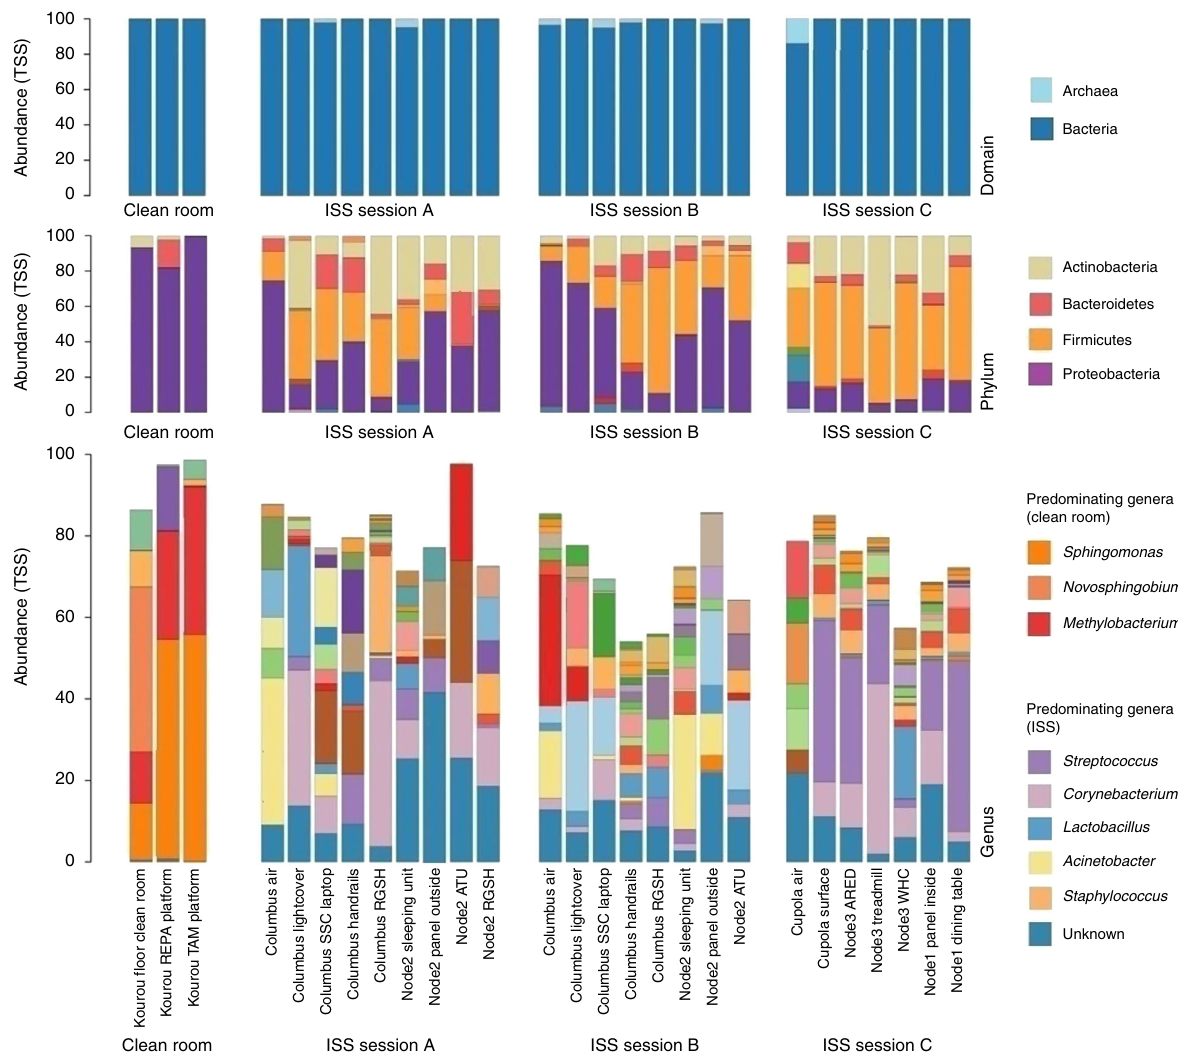
Fig. 1 Microbiome composition in clean rooms (left column) and the ISS. Samples were taken during session A, B, and C. A full version (with additional details) of the fi gure is available in the Supplementary Fig. microbiome composition (Supplementary Fig. 3c, d). Signatures